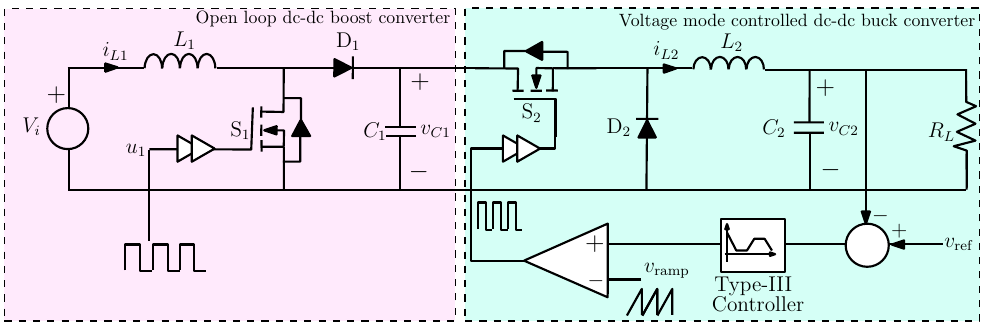
Figure 1. An open-loop boost converter loaded by a voltage-mode-controlled buck